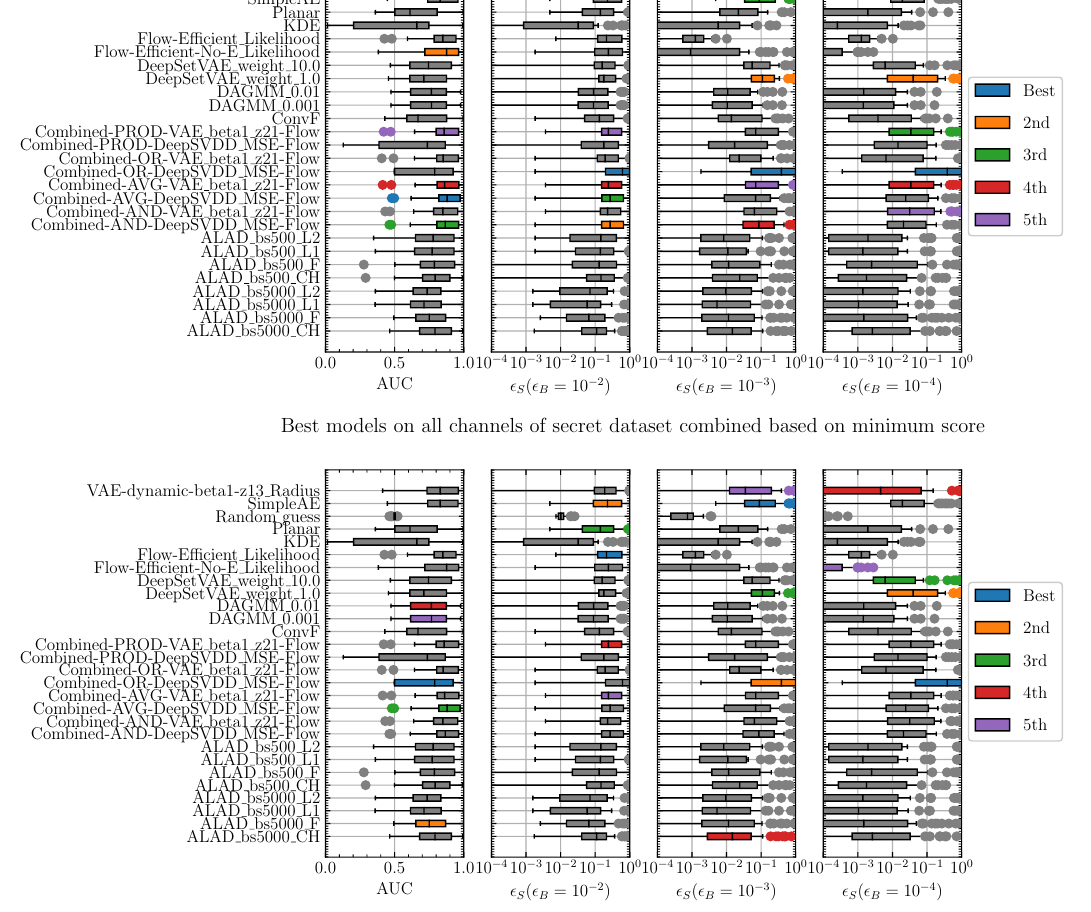
Figure 21: Box plots summarizing the anomaly detection techniques applied to the secret dataset. The colors denote the techniques that have the highest average rank (top), median score (middle) and minimum score (bottom) for each of the figures of merit described in Sec.